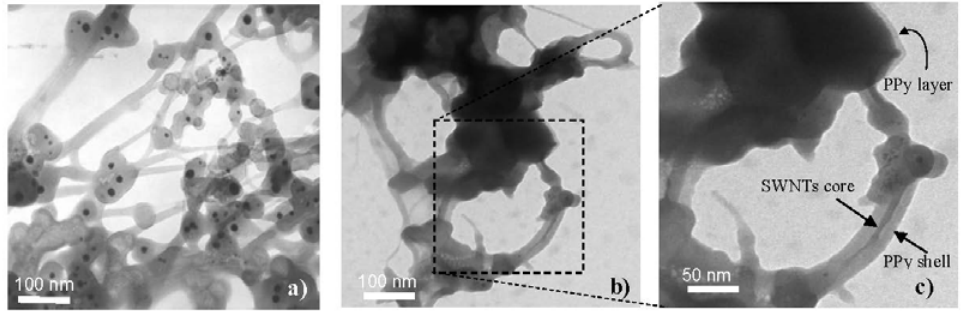
Figure 2. TEM images of SWNTs ( a ); PPy/SWNTs nanocomposites ( b ) and PPy layer/shell on the surface of amorphous carbon and out of SWNTs bundle core ( c